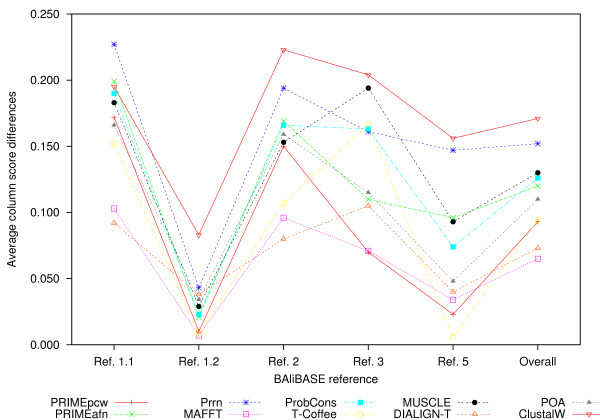
Average column score differences between full length and homologous region sets. Each point means average column score difference in respective alignments on each reference of the full length and homologous region sets. PRIMEpcw denotes PRIMEpiecewise, and PRIMEafn, PRIMEaffine. The smaller absolute value of a score indicates that the introduction of long terminal indels less affects the alignment accuracy of a program.